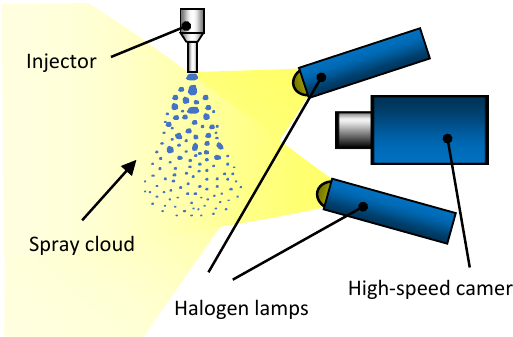
Figure 15. Experimental set-up for global spray parameters’ determination.